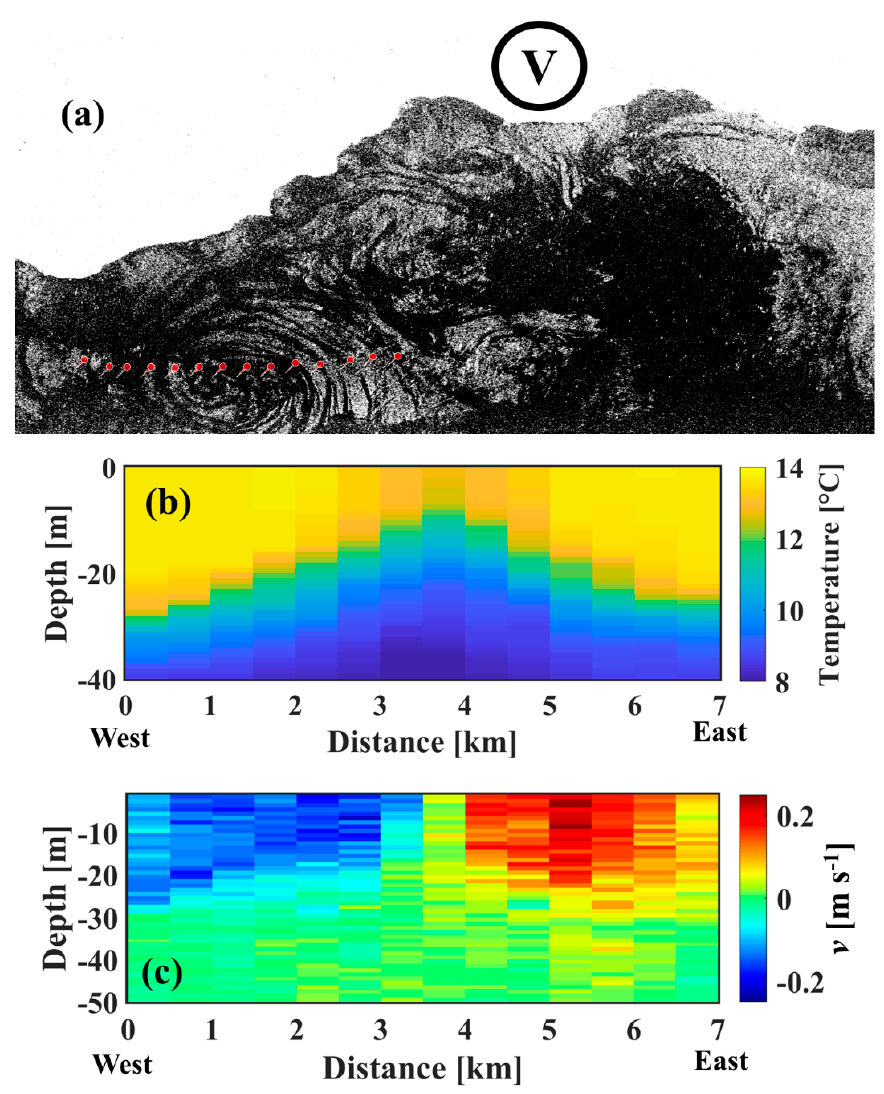
Figure 7. ( a ) Subset of a Sentinel-1A SAR-C image acquired on 26 October 2021 at 05:43 UTC. ( b ) Measured temperature (colorbar legend: temperature range) and ( c ) velocity (colorbar legend: horizontal velocity range) along the measurement points (red dots) in ( a ). Blue: southward currents; red: northward currents. V: reference point marked in Figure 1.